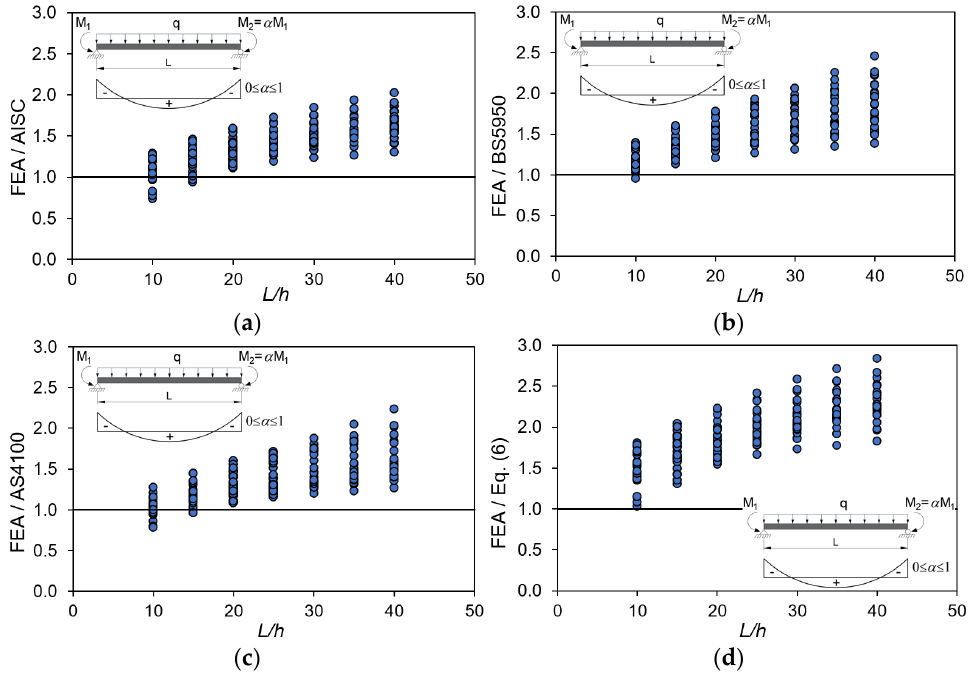
Figure 9. Comparison of elastic critical LTB for LC 1 between FEA results and existing equations.